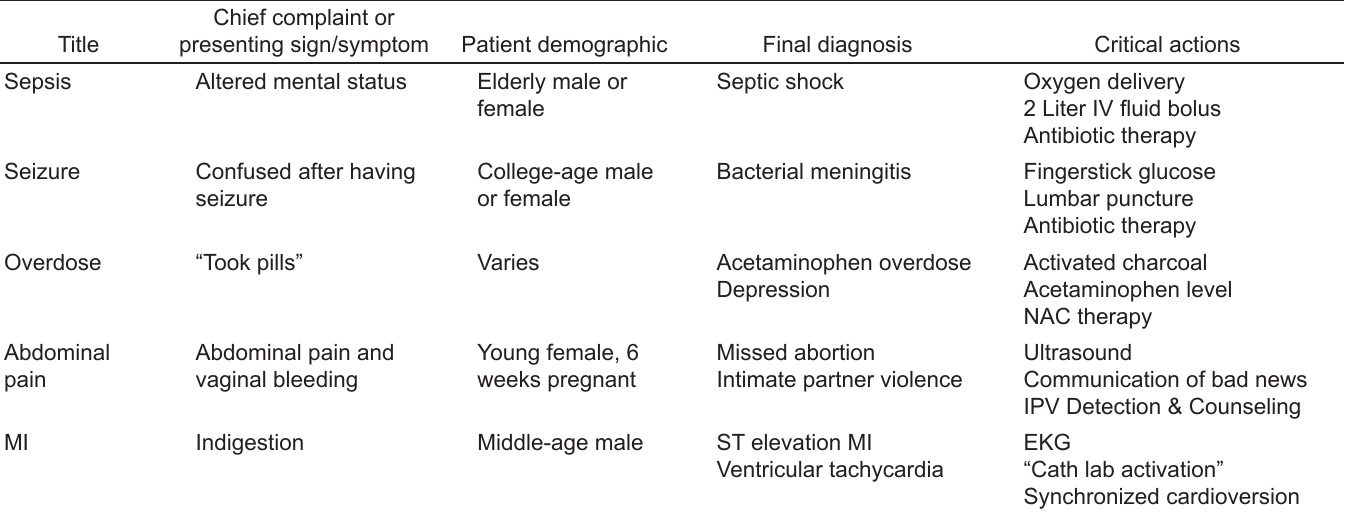
Table. OSCE case